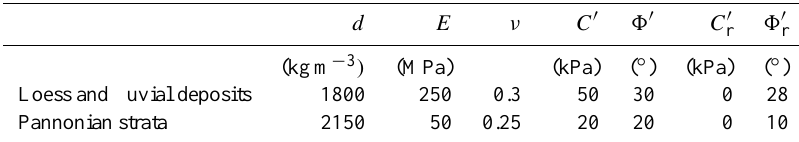
Table 3. Material properties used for FD-modelling: density ( d ), modulus of elasticity ( E ), Poisson ratio ( ν) , cohesion ( C 0 ), friction angle ( 8 ’); subscript “ r ” denotes residual values.